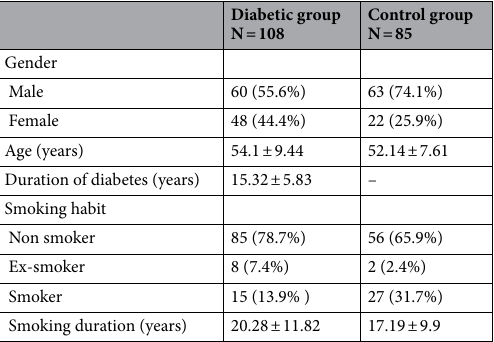
Table 1 mentioned to gender distribution, age, smoking habit as well as duration of smoking in both groups (diabetic patients and control groups). Duration of diabetes was shown to be less than 15 years. Table 2 illustrated high significant rise in serum glucose levels, cystatin-c and urinary hemeoxygenase, as well as significant decline in eGFR in diabetic groups compared with control group. Serum creatinine levels recorded non-significant change. Table 3 revealed high significant difference in distribution in genotype frequency of ACE G2350A gene ( p < 0.003) and significant distribution in ACE I/D gene ( p < 0.049) in diabetic patient compared with control group. Table 4 found significant difference in levels of HbA 1 C (%) and serum glucose in all genotypes of ACE G2350A gene. Also, GG genotype of ACE G2350A gene in diabetic patient group was associated with signifi- cant increase in levels of both serum cystatin-c and urinary HO-1. Mutant genotype AA was associated with significant increase in urinary HO-1 levels, while heterozygote genotype GA was associated with significant fall in eGFR levels in diabetic subjects compared with control ones. Table 5 found significant difference in levels of HbA 1 C (%) and serum glucose in all ACE I/D polymorphism. Also, DD polymorphism was associated with significant increase in levels of serum creatinine and cyst-c in diabetic patient group. Moreover, I/D polymorphism was associated with significant increase in urinary HO-1 levels and high significant decline in eGFR levels in diabetic patients compared with control group. Figure 1 showed significant positive correlation between duration of diabetes and level of serum cystatin-c in diabetic patient group (r = 0.22, p < 0.027).